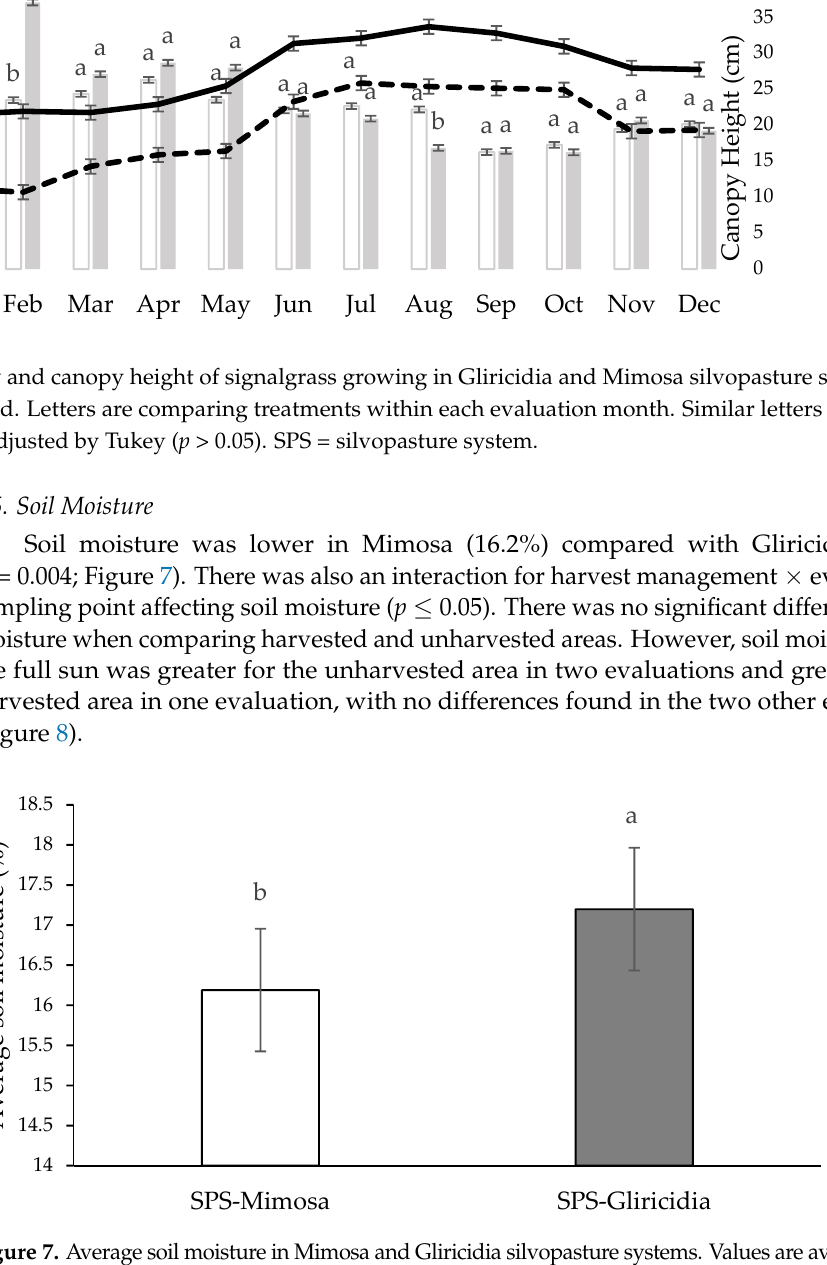
across months, replications, collection points, and harvesting management. SPS = silvopasture